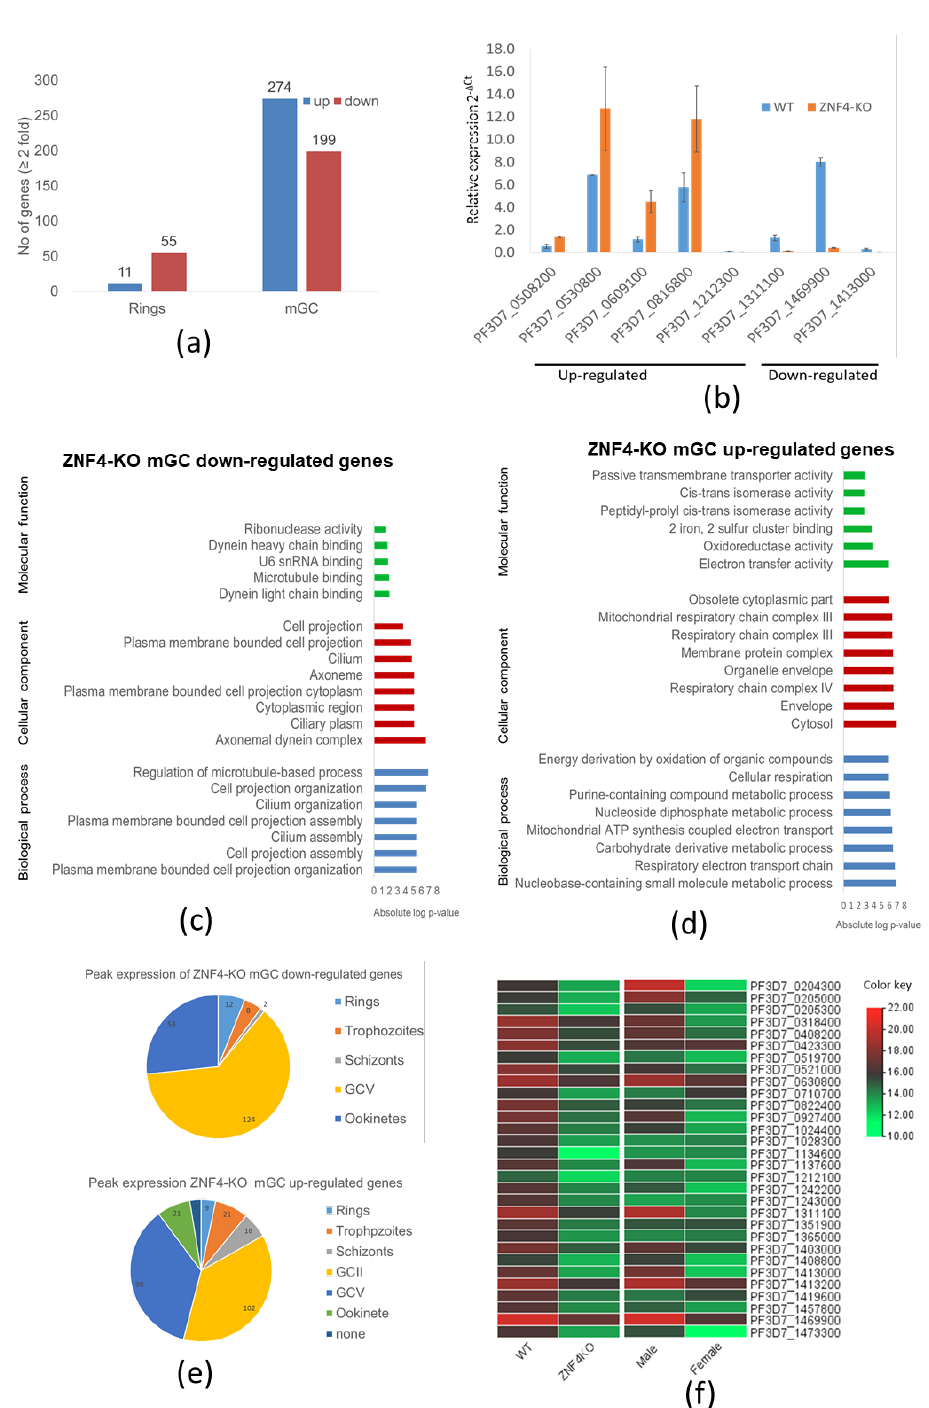
Figure 4. Deregulation of gene expression following disruption of ZNF4: ( a ) Comparative transcriptomics of deregulated genes in the ZNF4-KO parasite line in rings and mature gametocytes. Total RNA was extracted from ring stage parasites as well as the mature gametocytes of the ZNF4-KO and the WT and were subjected to comparative transcriptomics by RNA sequencing. Deregulated genes with relative gene expression greater than 2-fold were considered significant. ( b ) Validation of RNA-Seq data by qRT. Transcript analysis for 5 upregulated genes and 3 downregulated in mature gametocyte, as identified by RNA-Seq, were validated by real-time RT-PCR. Transcript expression levels were calculated by the 2 − ∆ Ct method; the threshold cycle number (Ct) was normalized with the Ct of the gene encoding seryl tRNA-ligase (PF3D7_0717700) as reference. Genes were considered upregulated when the changes between ZNF4-KO and WT sample were greater than